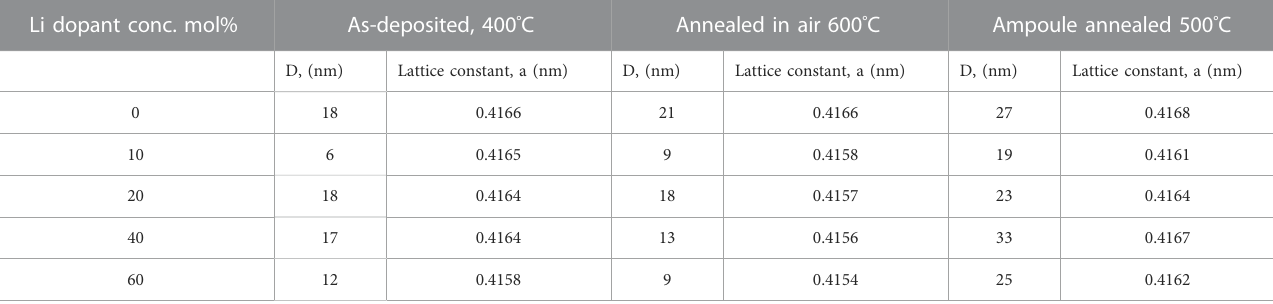
TABLE 2 Changes in the mean crystallite sizes (D) and lattice constant ( a ) of Li:NiO thin fi lms as a function of Li amount in solution for as-deposited fi lms and after different post-deposition treatment conditions. Li dopant conc. mol% As-deposited, 400 °